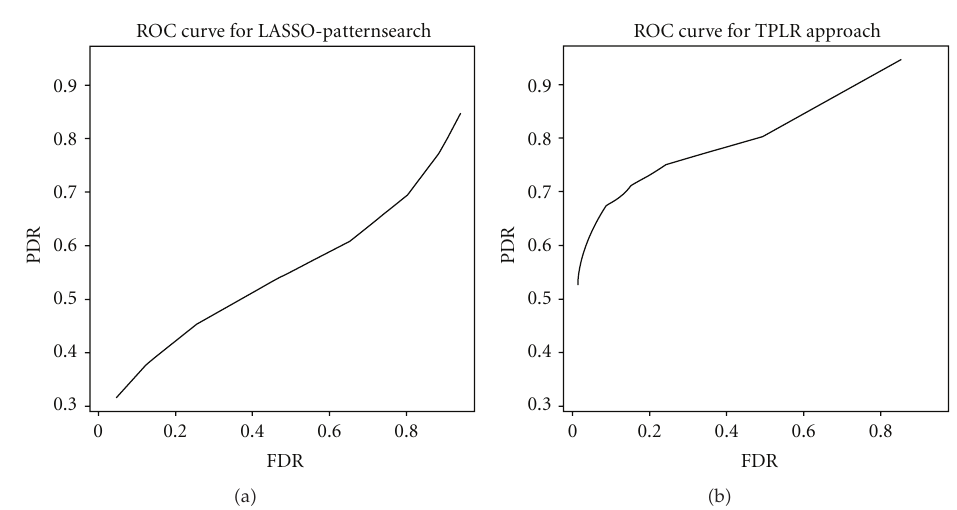
Figure 1: The ROC curves of the LASSO-patternsearch and the TPLR approach for identifying etiological